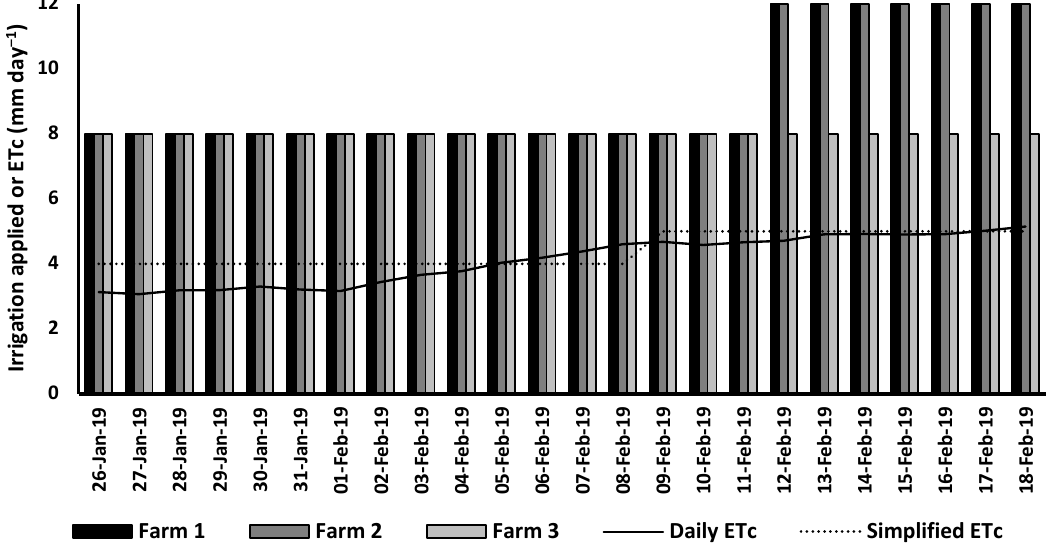
Figure 3. Daily application measured during demonstration trials on three farms in Chhouk, Kampot Province, Cambodia, showing differences in the amount of water applied to similar crops in similar growing conditions, and compared to predicted ET c , and a simplified form of ET c used for demonstration of an alternative irrigation schedule.